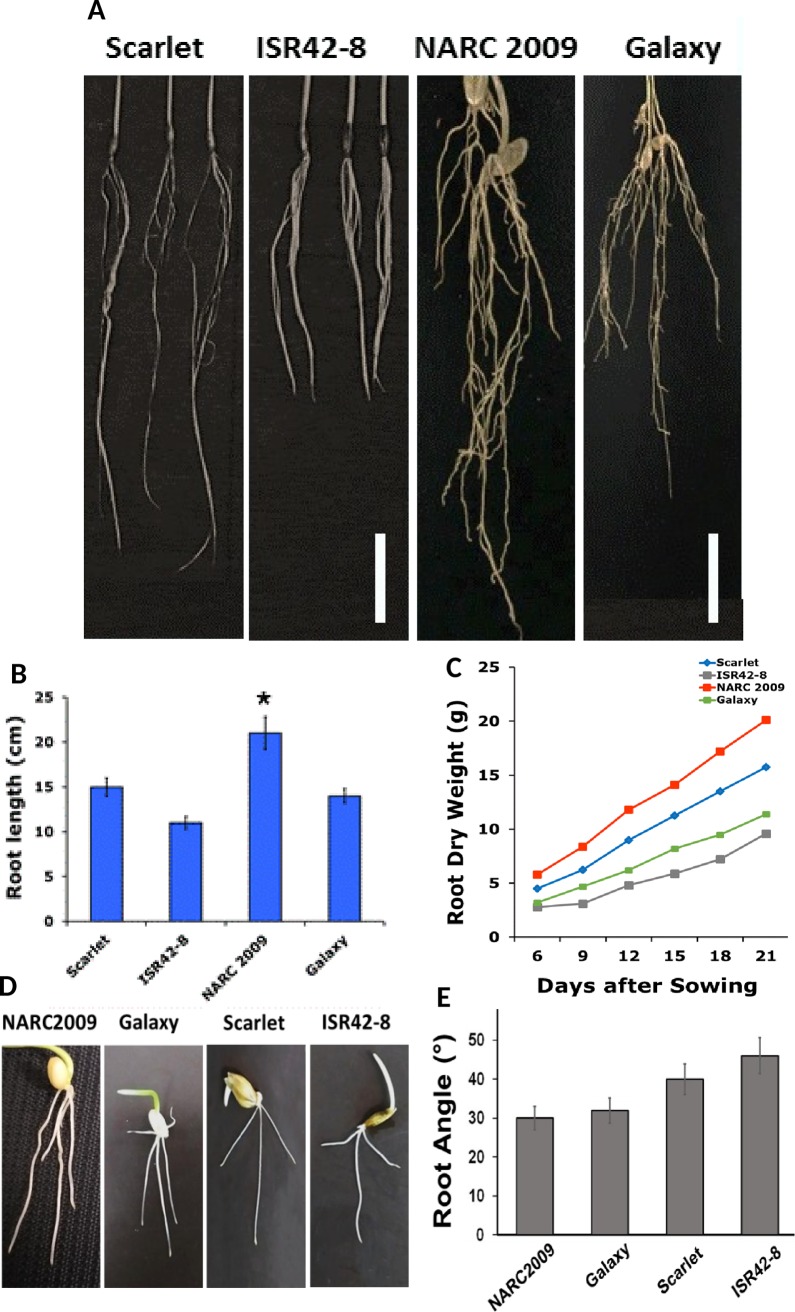
Morphological comparison of root architecture in wheat and barley cultivars.(A) Photographs showing the roots of 6-day old plantlets of wheat varieties “NARC 2009 and Galaxy” and barley cultivars “Scarlet and ISR42-8”. Scale bars indicate 4 cm. (B) Graph showing root length comparisons of wheat and barley. Error bars indicate the standard deviation. * Significant (P<5%). (C) Line graph depicting the trend in total root dry weight in 6 to 21 days old plantlets of wheat and barley. (D) Photographs exhibiting root growth angle on MS media in wheat and barley cultivars. (E) Graphical representation of variations in root angle of wheat and barley cultivars. Root angle was measured by ImageJ software.